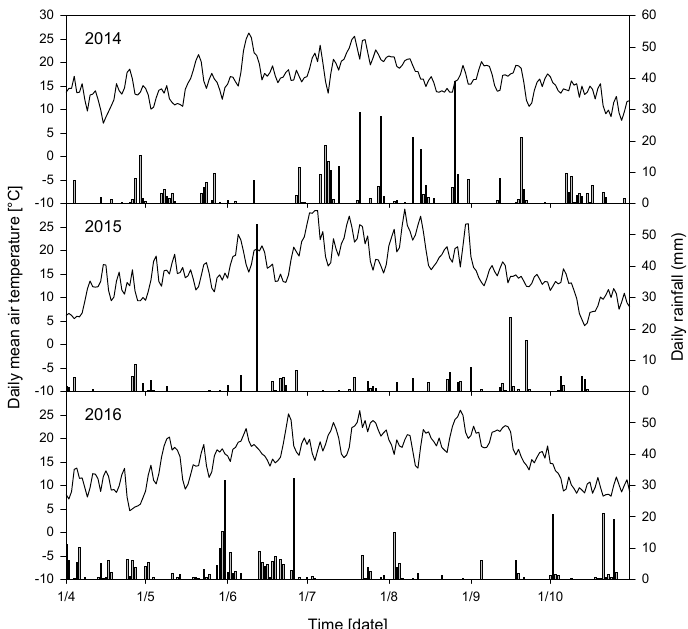
Figure 1. Mean air temperature (solid line) and daily rainfall (black bars) during vegetation periods (1 April to 31 October) 2014, 2015 and 2016 at the Geisenheim